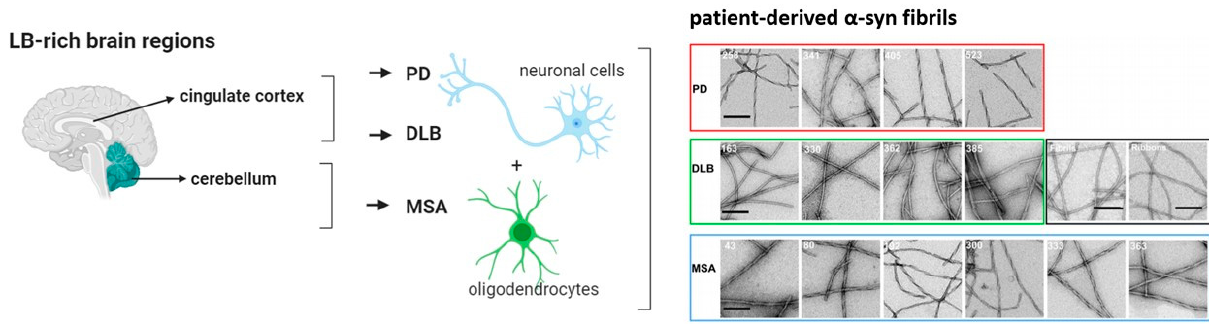
Figure 1. Simplified illustration of the differences of α -syn deposition and structure in PD, DLB, and MSA neurodegenerative diseases. In particular, LB-rich brain regions deposited in the cingulate cortex are thought to be specific for PD and DLB, while depositions within the cerebellum are specific for MSA. Additionally, inclusions of α -syn are found in neuronal cells in PD and DLB. Conversely, in MSA these inclusions are found in oligodendrocytes (( left ), visualized with BioRender). Structural differences of α -syn have been reported in patient-derived α -syn fibrils ( right ). (Adapted from [24] and visualized with